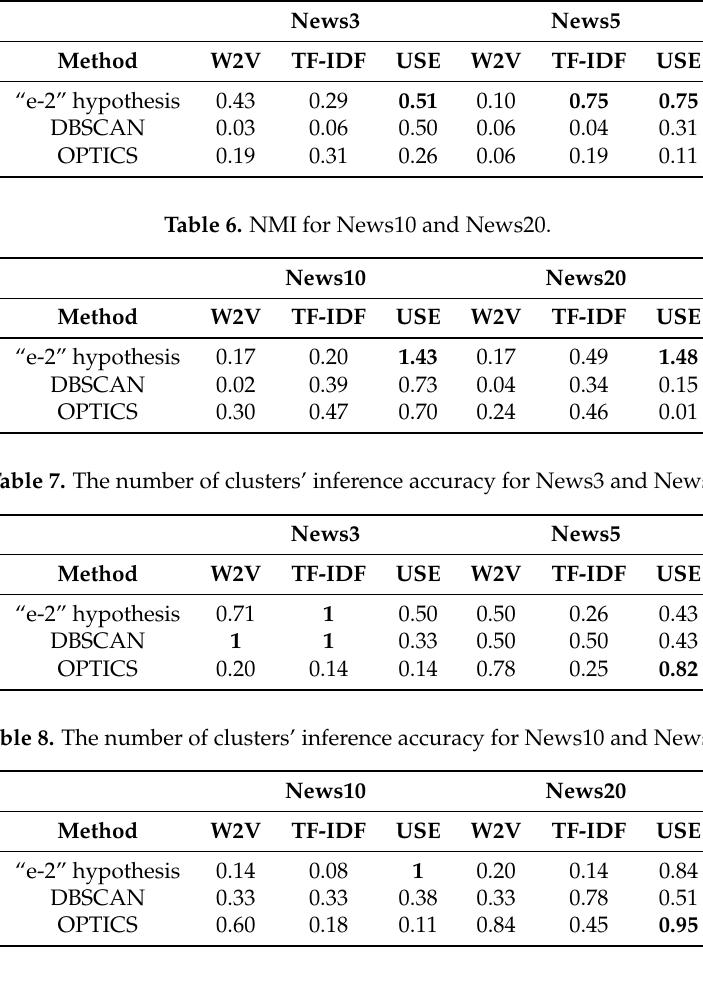
Table 9. Results for BBC dataset (Universal Sentence Encoder (USE) data